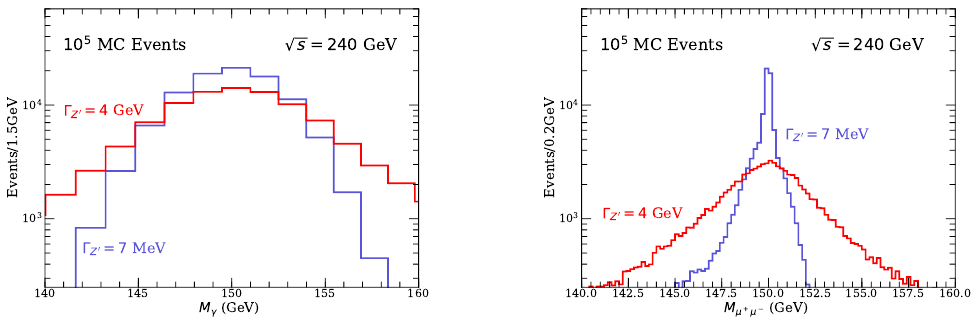
Figure 12 . Left panel: M (cid:13) distribution in e + e (cid:0) ! (cid:13)Z 0 ! (cid:22) (cid:31)(cid:31)(cid:13) in the CEPC H -mode, where M (cid:13) = p p s (cid:0) 2 sE (cid:13) . Right panel: M e + e (cid:0) ! (cid:13)Z 0 ! (cid:22) + (cid:22) (cid:0) (cid:13) in the CEPC H (cid:22) + (cid:22) (cid:0) distribution in